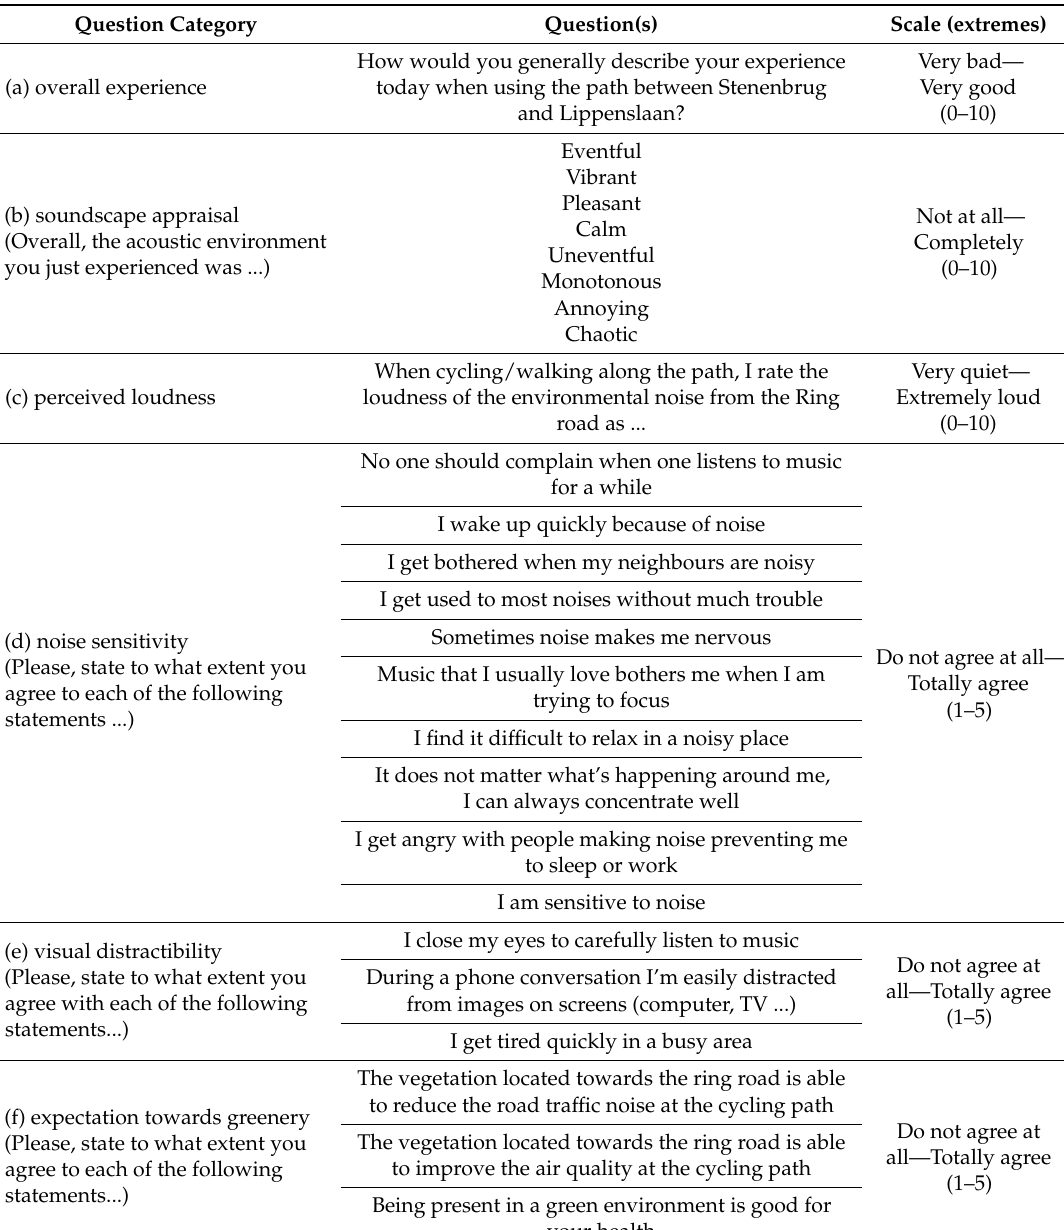
Table 1. Summary of the onsite questionnaire. The information about the questions’ categories was not revealed to